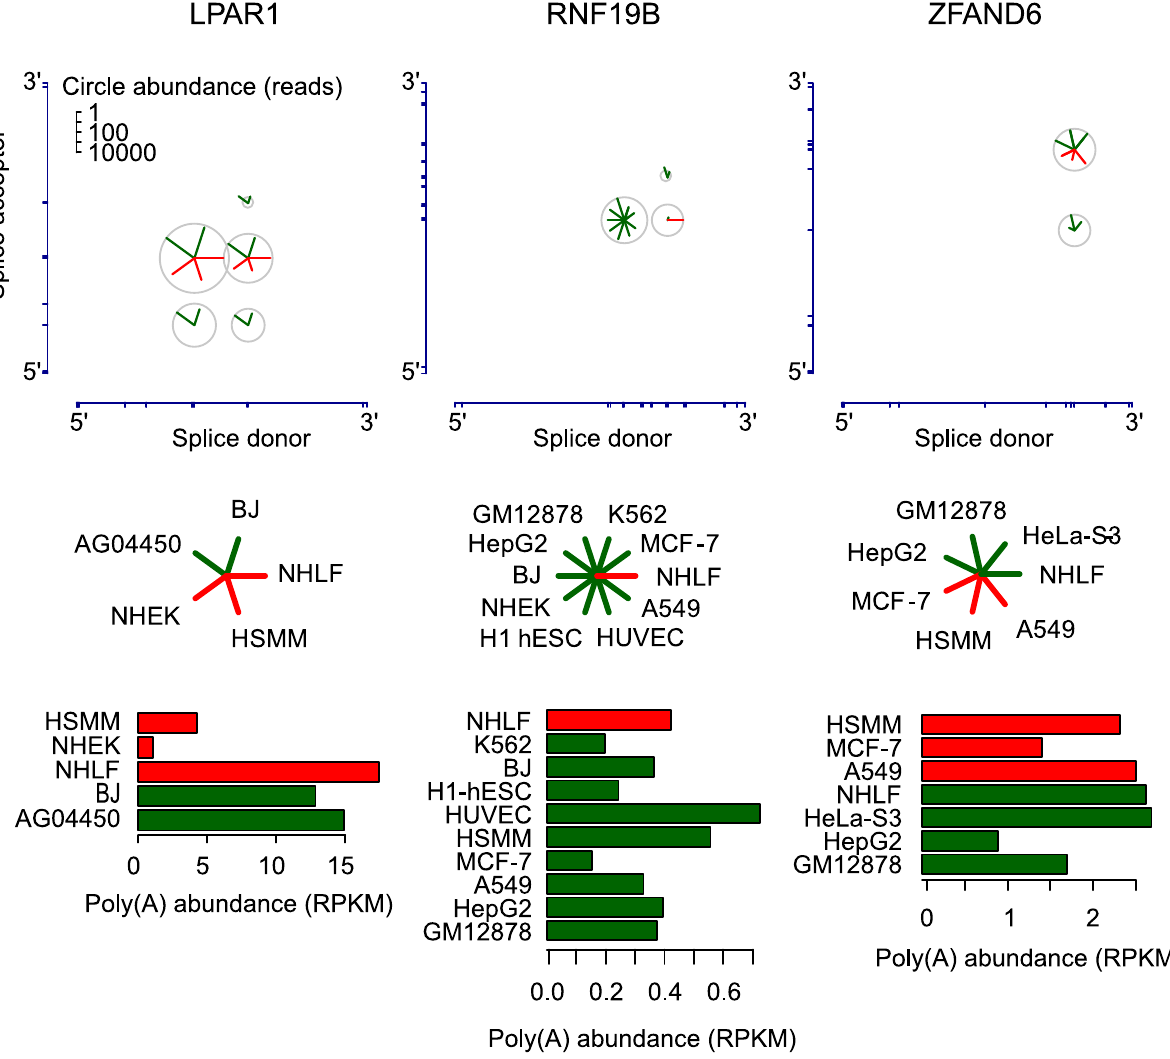
Figure 8. Circular isoform expression is regulated within individual genes. Circular isoform expression across cell types is shown for LPAR1, RNF19B, and ZFAND6 as in Fig. 6. The barplots depict expression of the corresponding linear isoforms in RPKM units. Cell types are colored as red or green to highlight distinct patterns of circular isoform expression. Differential circular RNA isoform expression in LPAR1, RNF19B and ZFAND6 cannot be explained by differences in expression level of polyadenylated transcripts of these genes or sampling